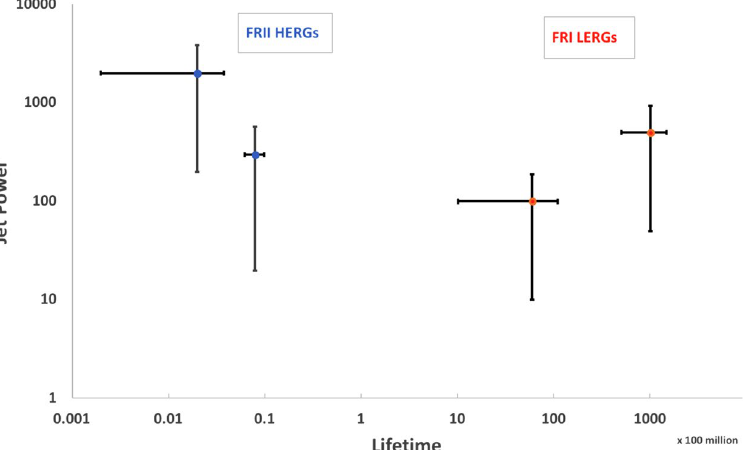
Figure 3. Jet power in units of (B 5 m 9 ) 2 where B 5 is the magnetic field in units of 10 5 Gauss and m 9 is the black hole mass in units of 10 9 solar masses, versus lifetime (in units of 10 8 years) for FRII HERGs and FRI LERGs from the gap paradigm. The two FRII HERGs in blue correspond to Fig. 2 paths a & b higher jet power, smaller lifetime, and path c, lower jet power, longer lifetime. The two FRI LERGs in red correspond to paths b, lower jet power and shorter lifetime and path c, higher jet power and longer lifetime. Fractional uncertainties in jet power of order unity or greater emerge just from the possible range of black hole threading magnetic field strengths. The active lifetime uncertainty for LERGs is much greater than for HERGs, since the latter are constrained by Eddington-limited accretion in retrograde mode 62–65